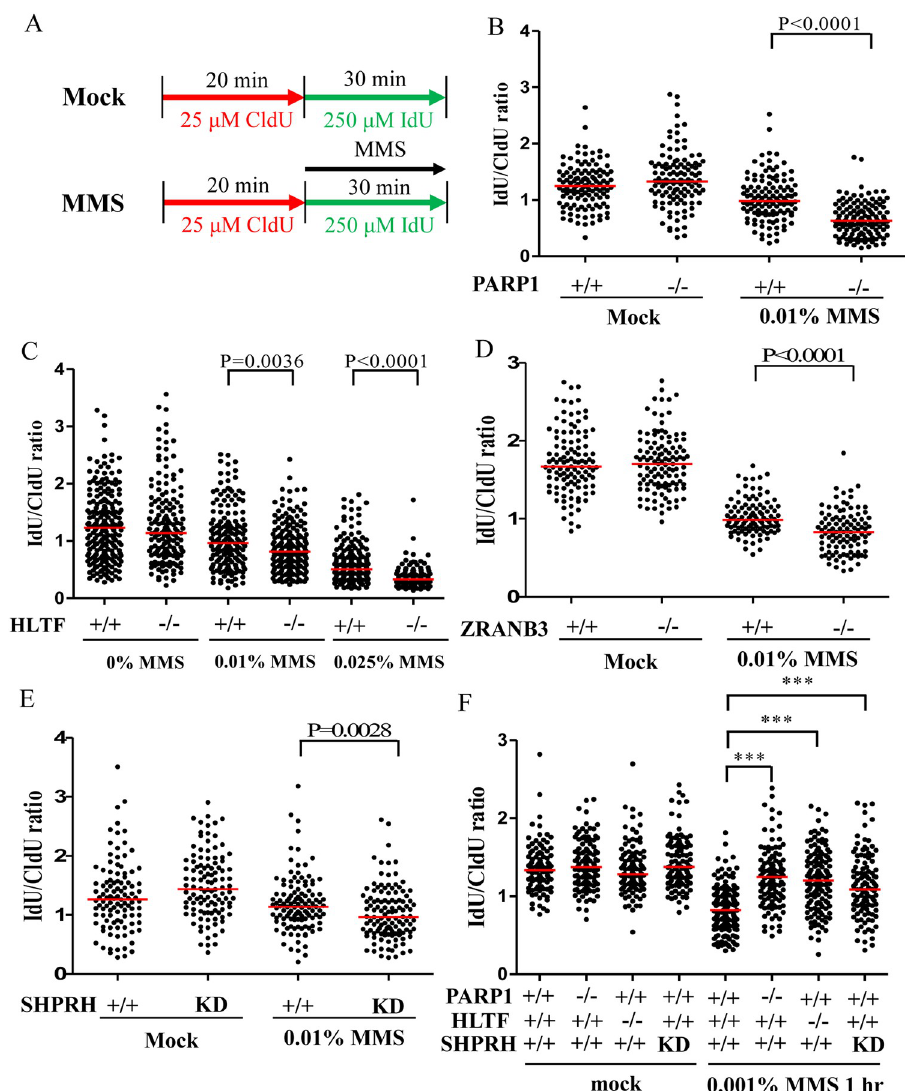
Fig 7. DNA fiber analysis upon MMS-induced replication stress. (A) Labeling protocols for DNA fiber analysis. (B) - (F) Quantitation of IdU/CldU track length ratios derived from each cell line. At least 100 DNA fibers derived from each cell line were measured. (Raw DNA fiber data in S7